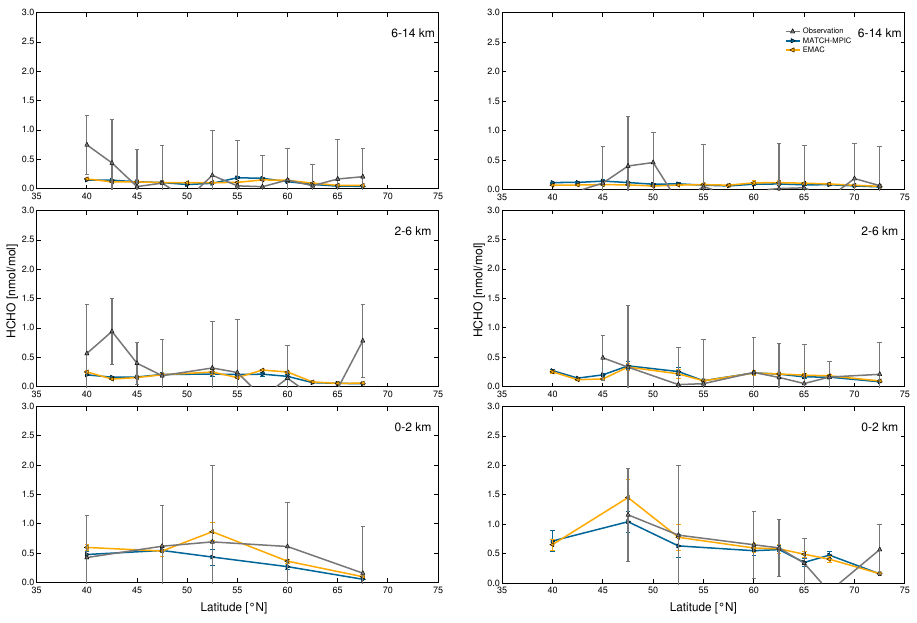
Fig. 8. Latitude gradients of HCHO for HOOVER 1 in October 2006 (left panels) and HOOVER 2 in July 2007 (right panels). Data is subdivided into 3 altitude intervals representing the BL, the MT and the UT. The median values of in-situ measurements (grey), EMAC simulations (orange) and MATCH-MPIC simulations (blue) are shown together with 2 sigma as error bars. 22 Klippel et al.: Hydrogen peroxide and formaldehyde over Europe